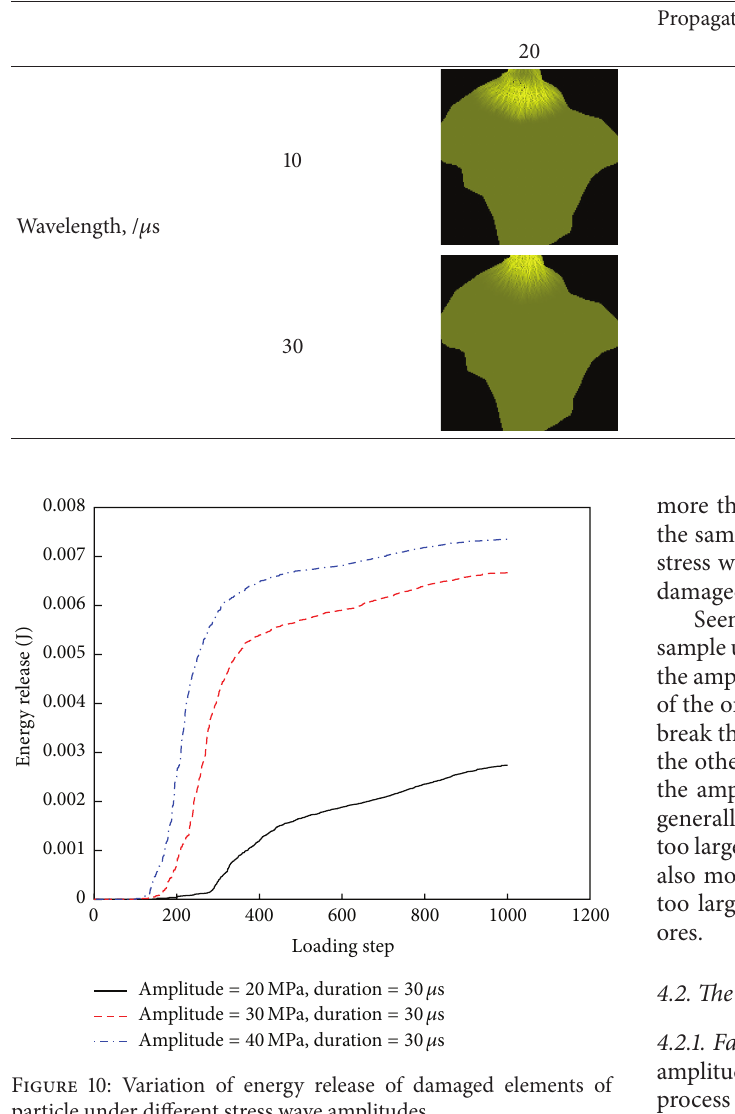
Table 3: Failure process of the sample under different wavelengths (stress amplitude is 20MPa).